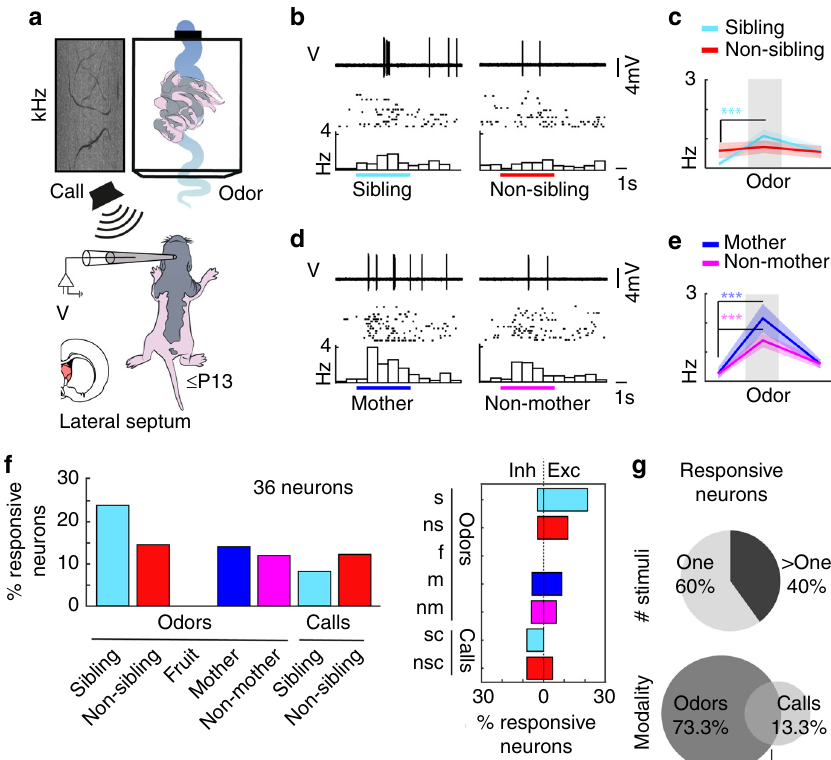
Fig. 4 Responses of lateral septum neurons to kin stimuli in sibling-preferring young pups. a Juxta-cellular recordings of anaesthetized ≤ P13 pups with odor and vocalization stimuli. b Responses to sibling and non-sibling odor (top), raster (middle), and peristimulus time histogram (bottom). Colored lines: timing of odors. c Firing rates for baseline (left), odor (middle), and offset (right). Data represent the mean (thick line) ± s.e.m. (shaded area). Sibling